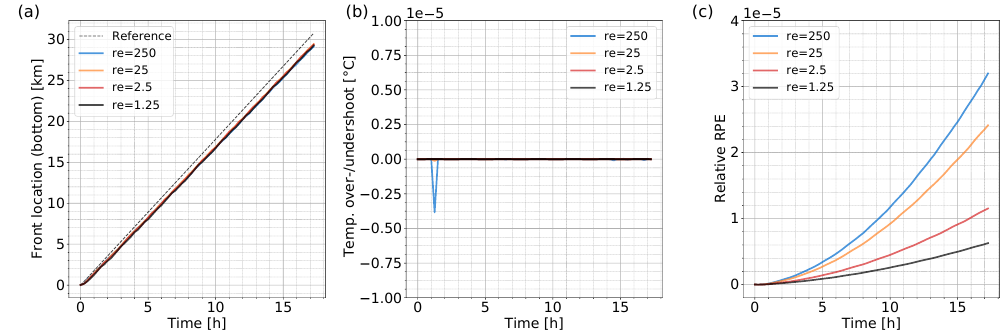
Figure 4. Diagnostics of the lock exchange test. (a) Location of the density front at the bottom of the domain, (b) over- and undershoots in the temperature field (with regard to to 30.0 and 5.0 ◦ C, respectively), and (c) normalized reference potential energy (RPE) versus simulation